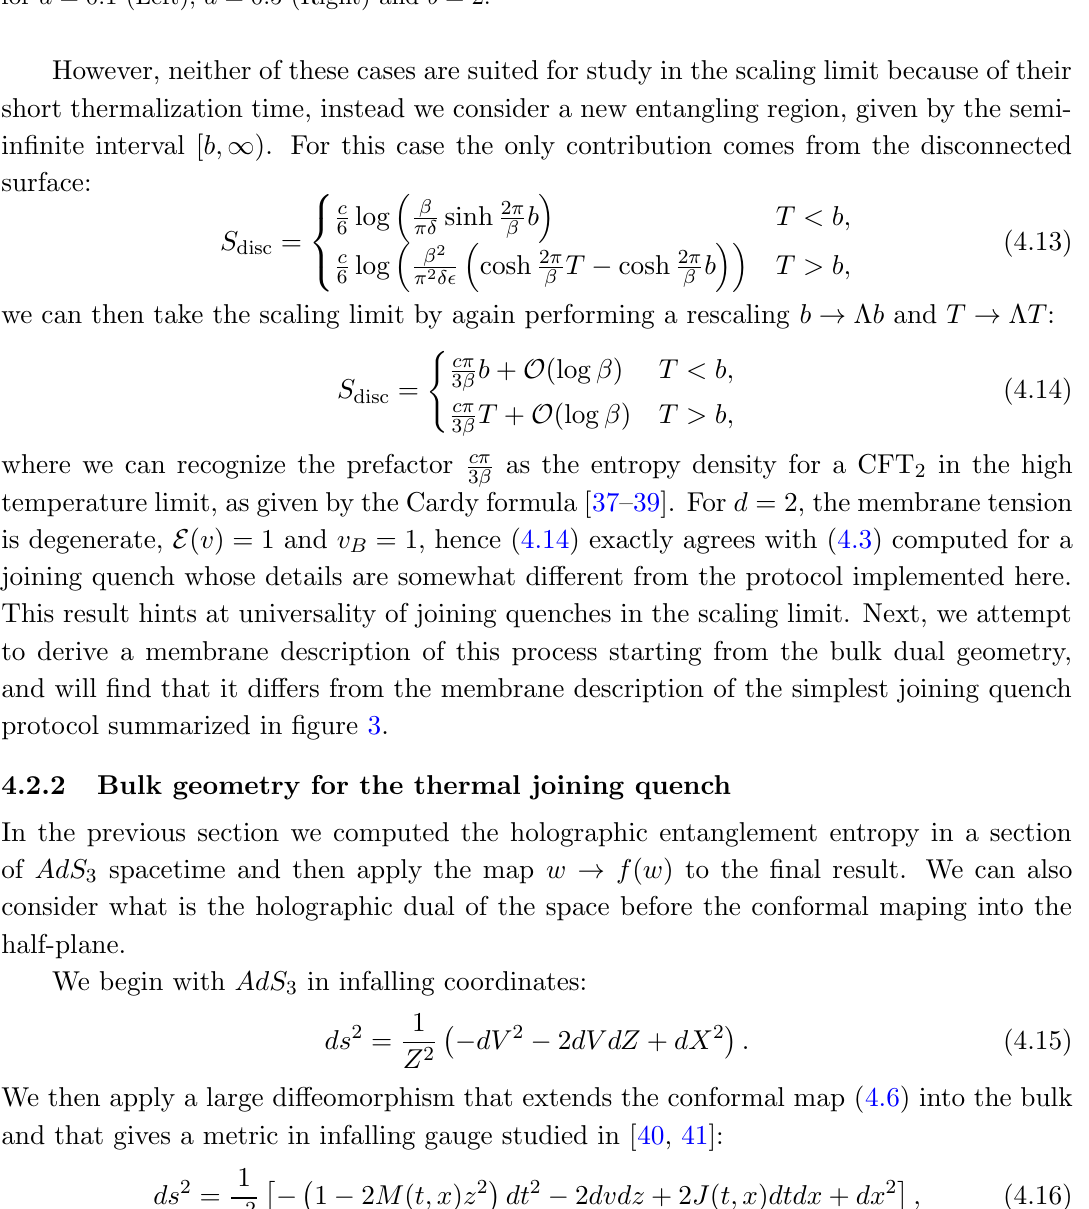
Figure 5 . Connected (Blue) and Disconnected (Red) contributions to the entanglement entropy for a = 0 : 1 (Left), a = 0 : 5 (Right) and b =